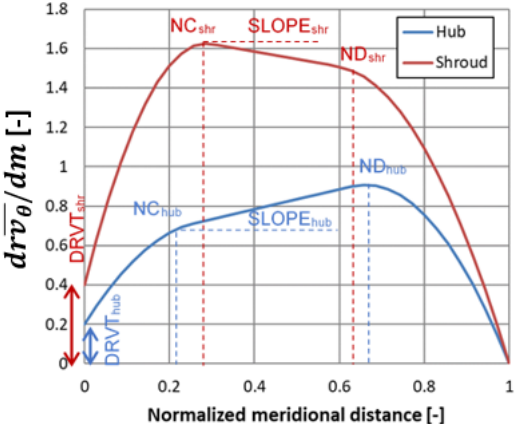
Figure 3. Streamwise blade loading defined using three-segment method.